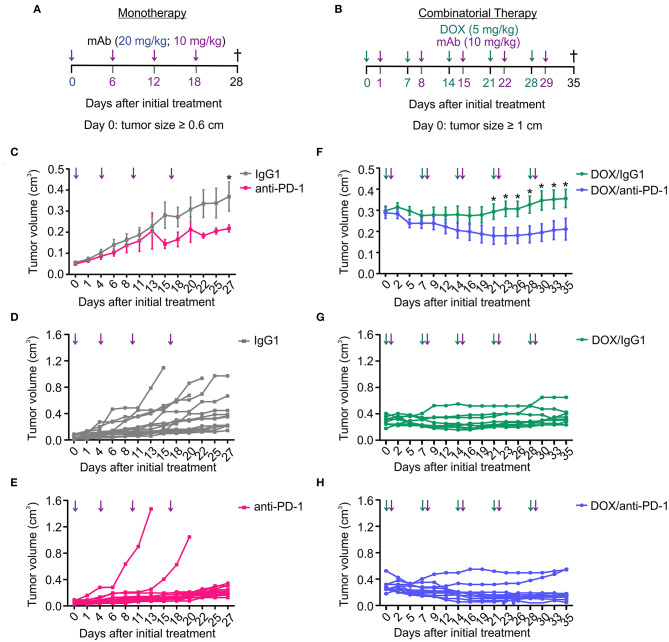
Combination of chemotherapy and PD-1 blockade improves tumor control in the PyMT model. Treatment regimens for anti-PD-1 monotherapy and doxorubicin (DOX) plus anti-PD-1 combinatorial therapy. (A) Treatment regimen of monotherapy. PyMT tumors were treated with either anti-PD-1 or isotype control (IgG1) antibody (i.p.) every 6 days for 18 days (day 0 = 20 mg/kg; day 6, 12, 18 = 10 mg/kg) once the first tumor reached a size of 0.6 cm in diameter. (B) Treatment regimen of combinatorial therapy. PyMT tumors were treated with 5 mg/kg doxorubicin (DOX) (i.p.) and with 10 mg/kg of either anti-PD-1 or isotype control (IgG1) antibody (i.p.) once weekly for 5 weeks once the first tumor reached a size of 1 cm in diameter. (C,F) Cumulative tumor volume (length × width2 × π/6) of primary tumors upon (C) monotherapy (n = 17 each) and (F) combinatorial therapy (DOX/IgG1: n = 11, DOX/anti-PD-1: n = 10) over time are shown, as well as the individual tumor volumes for (D,E) monotherapy and (G,H) chemoimmunotherapy. Data are means ± SEM, p-values were calculated using unpaired t-test; *p < 0.05.